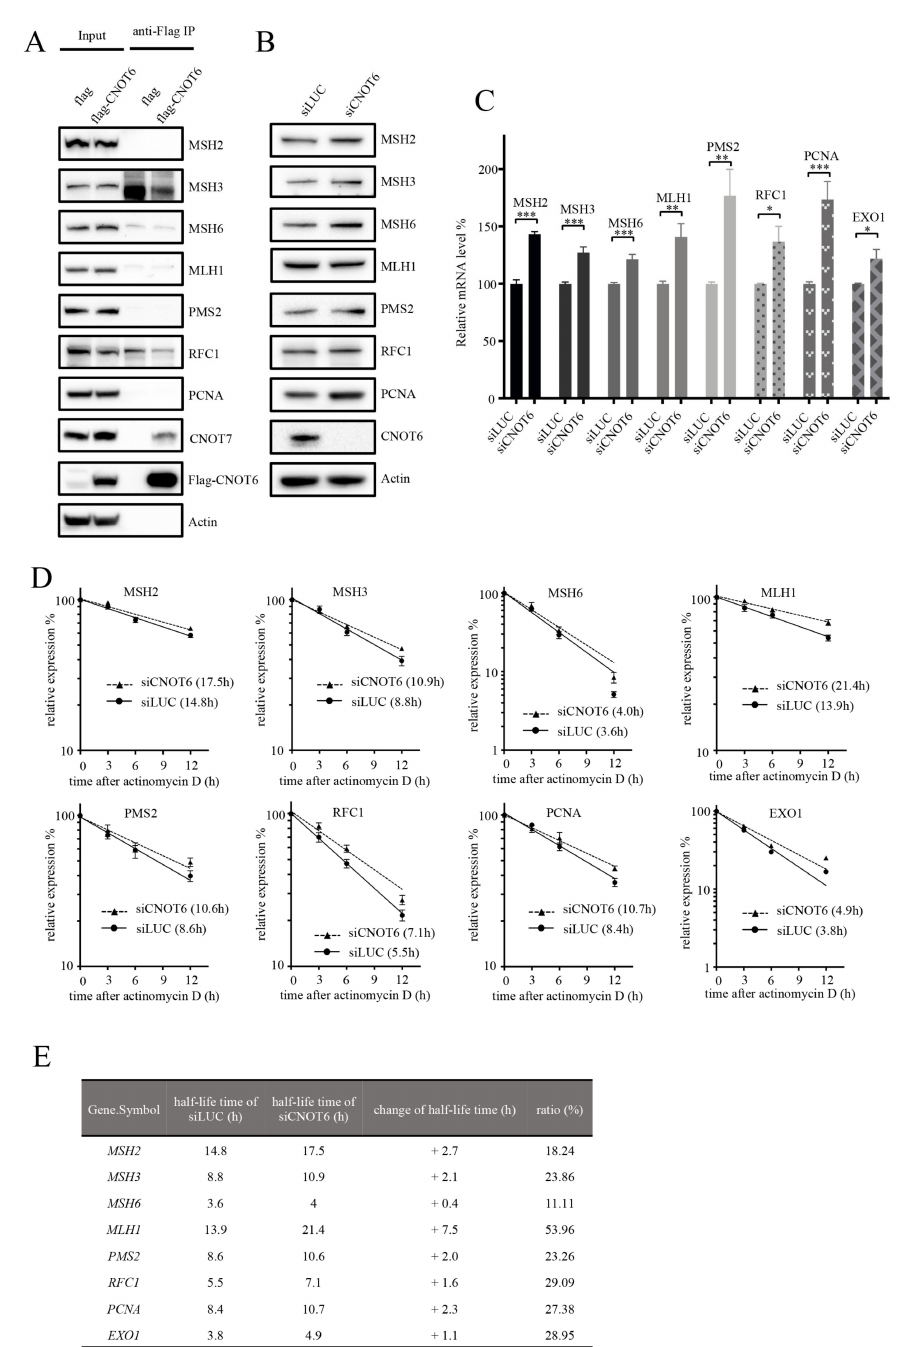
Figure 3. CNOT6 deficiency stabilizes MMR mRNA transcripts. ( A ) U2OS cells transiently overex- pressing Flag-tagged-CNOT6 were collected and lysed, and cell extracts used for anti-Flag immuno- precipitation. Representative immunoblots for the indicated proteins are shown. ( B ) Representative immunoblots for the indicated MMR factors using extracts from CNOT6-depleted cells. ( C ) Real-time quantitative PCR was performed to quantify expression of the indicated MMR genes in CNOT6- depleted cells. Data are shown as mean ± SEM, n = 3; statistical significance (* p < 0.5, ** p < 0.01, *** p < 0.001) was determined using unpaired two-tailed Student’s t test. ( D ) The half-life of MMR gene transcripts in control and CNOT6-depleted cells with the treatment of transcriptional inhibitor Actinomycin D is shown. n = 3. ( E ) Data from panel D are compared to demonstrate the effect of CNOT6-depletion on the half-life of MMR gene